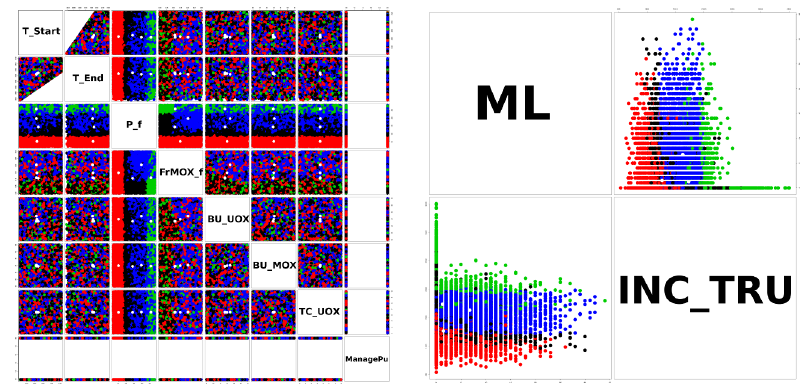
Figure 1: Clusters of trajectories from clustering on INC TRU